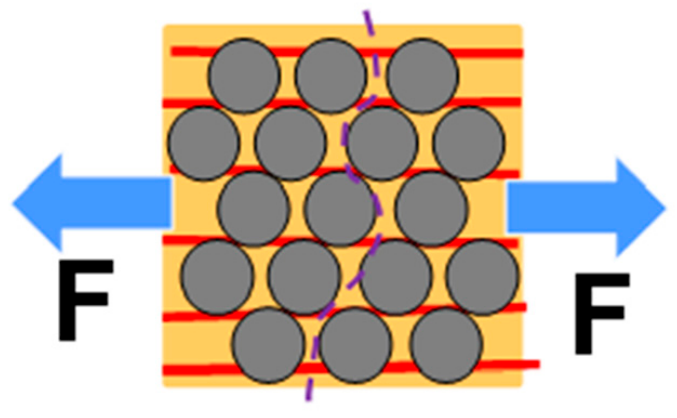
Figure 10. Illustration of CHM unidirectional ply. The CNT strands must be pulled out over many CFs to cause failure in the direction transverse to the fiber. Table 1. Expected volume fractions of components in a CNT-CF composite. Composite Material